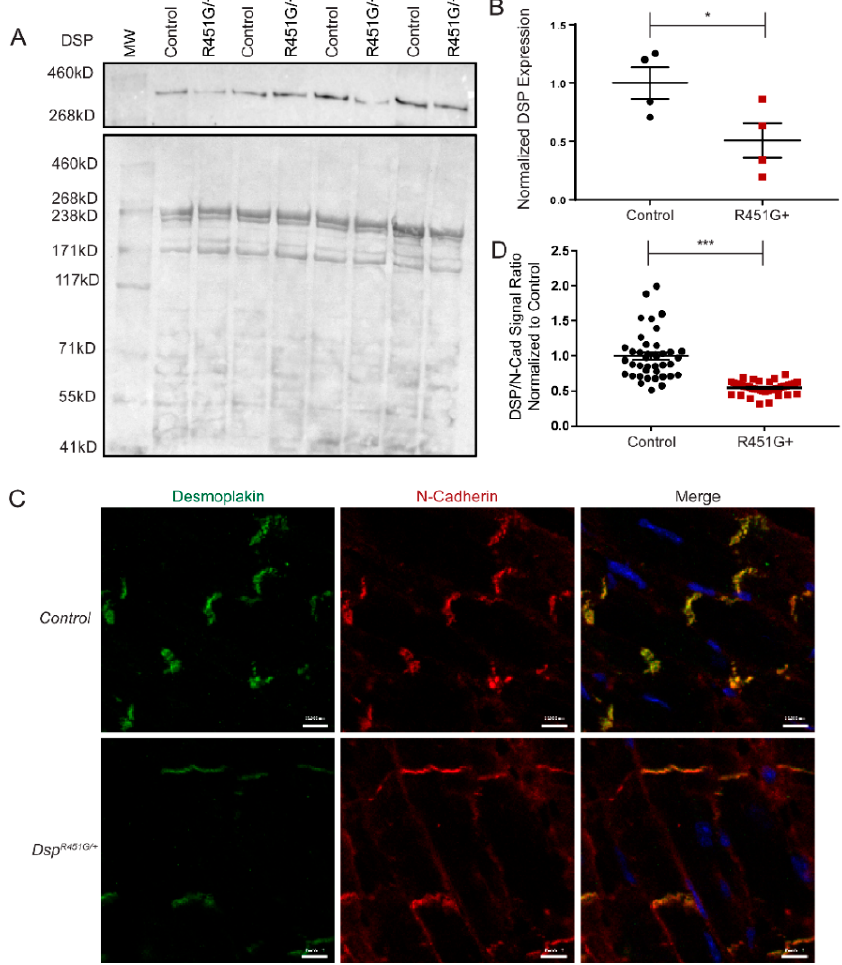
Figure 2. Dsp R451G/+ mice display a reduction in DSP protein expression. ( A ) Representative im- munoblot of heart lysates from Dsp R451G/+ and control littermates isolated at 6 months of age, com- paring full length DSP levels ( n = 4 per group). Ponceau staining included. ( B ) Quantification of immunoblotting of DSP normalized to Ponceau staining. Stats performed using Student’s t -test * p < 0.05. ( C ) Immunostaining of cardiac cryosections examining DSP localization and expression pat- terns at the intercalated disc, using N-cadherin as a control marker ( n = 4 per genotype). Scale bars represent 10 µm. ( D ) Quantification of DSP/N-Cad signal intensity ratios. n = 4 animals per geno- type, n = 10 IDs analyzed per animal; stats performed using Student’s t -test *** p < 0.001.